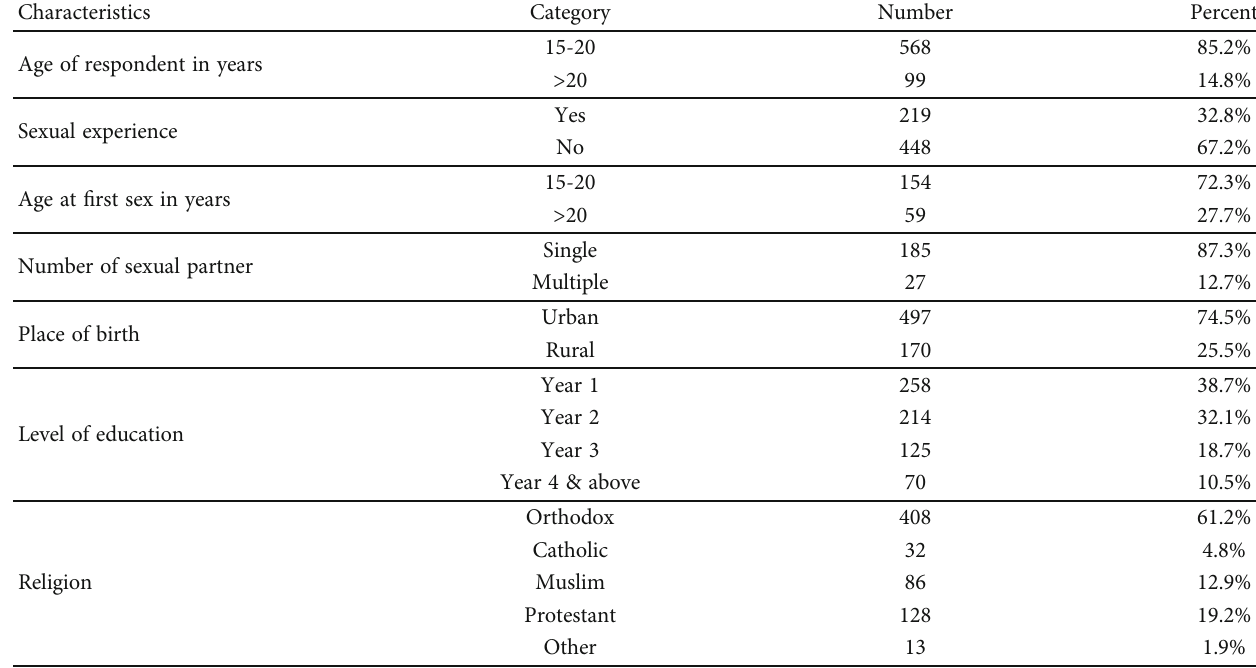
Table 1: Sociodemographic characteristic of respondents for KAP of Cervical Screening at Adama Science and Technology University Adama, Ethiopia, May